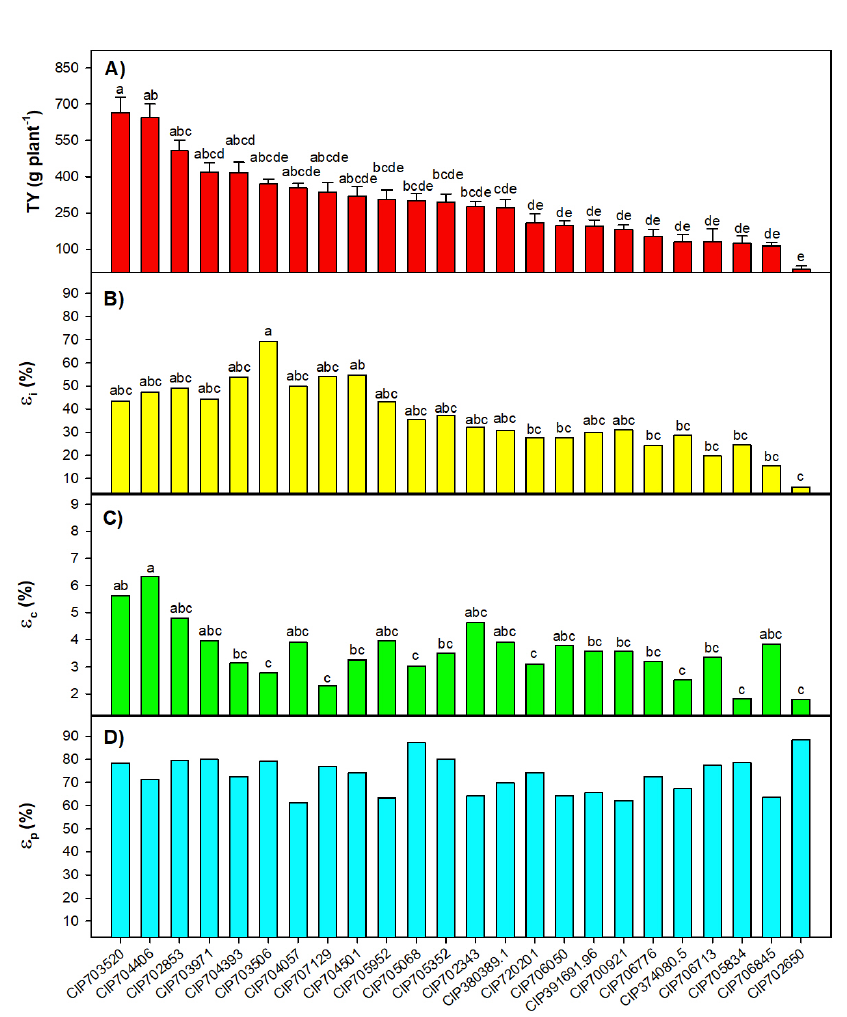
Figure 1. Adjusted mean values of TY—dry tuber yield per plant ( A ); ε i —radiation interception ( B ), ε c —conversion ( C ) and ε p —partitioning efficiency ( D ) per accession. Different letters mean